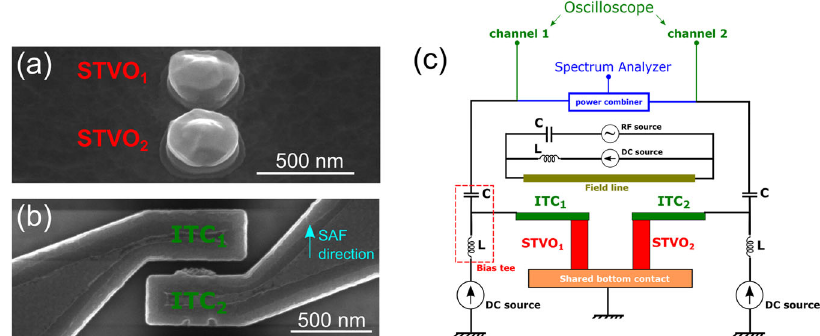
Fig. 1 Device layout. a Scanning electron microscopy (SEM) image obtained after dry etching de fi nition for a pair of magnetic tunnel junctions (MTJs). The nanopillars have a nominal diameter of 300 nm and a nominal edge-to-edge (d ee ) distance of 100 nm. The image is obtained at a viewing angle of 40° with respect to the perpendicular direction. b Top view SEM image obtained after dry etching de fi nition of a pair of individual top contacts (ITCs) establishing electric contact to a pair of MTJs with d ee = 100 nm. The blue arrow indicates the pinning direction of the reference synthetic antiferromagnetic (SAF) structure. c Illustration of the experimental setup used for the characterization of MTJ nanopillars with independent top